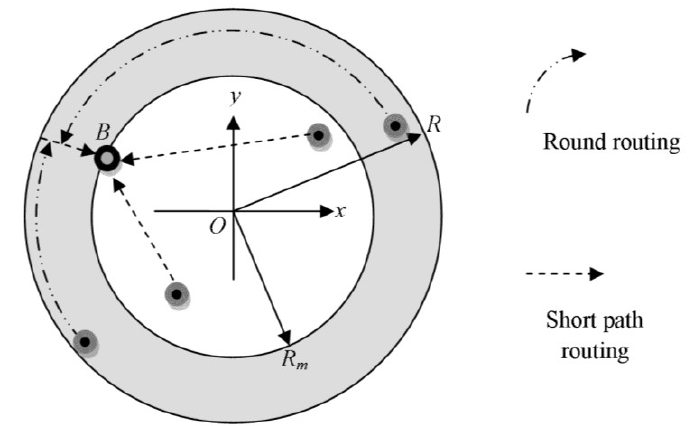
Figure 4. Joint routing mechanism and sink mobility